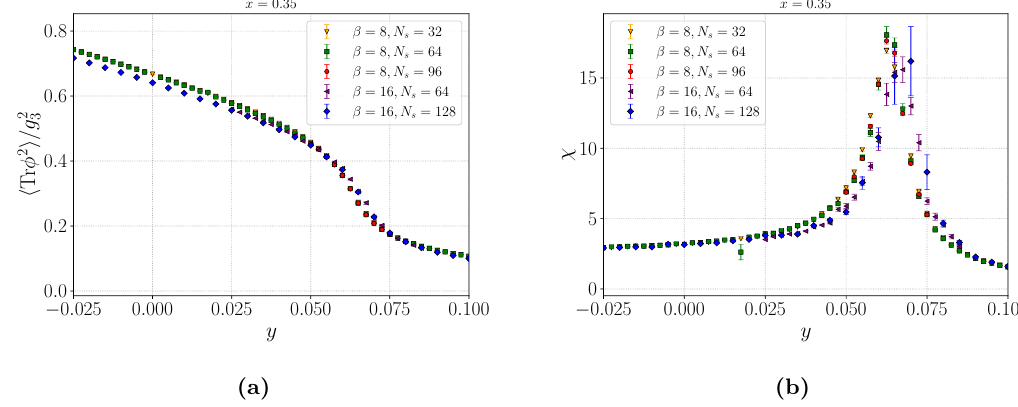
Figure 3 . (a) Quadratic Higgs condensate at different lattice spacings ag 2 MS scheme. (b) Volume and β dependence of the susceptibility